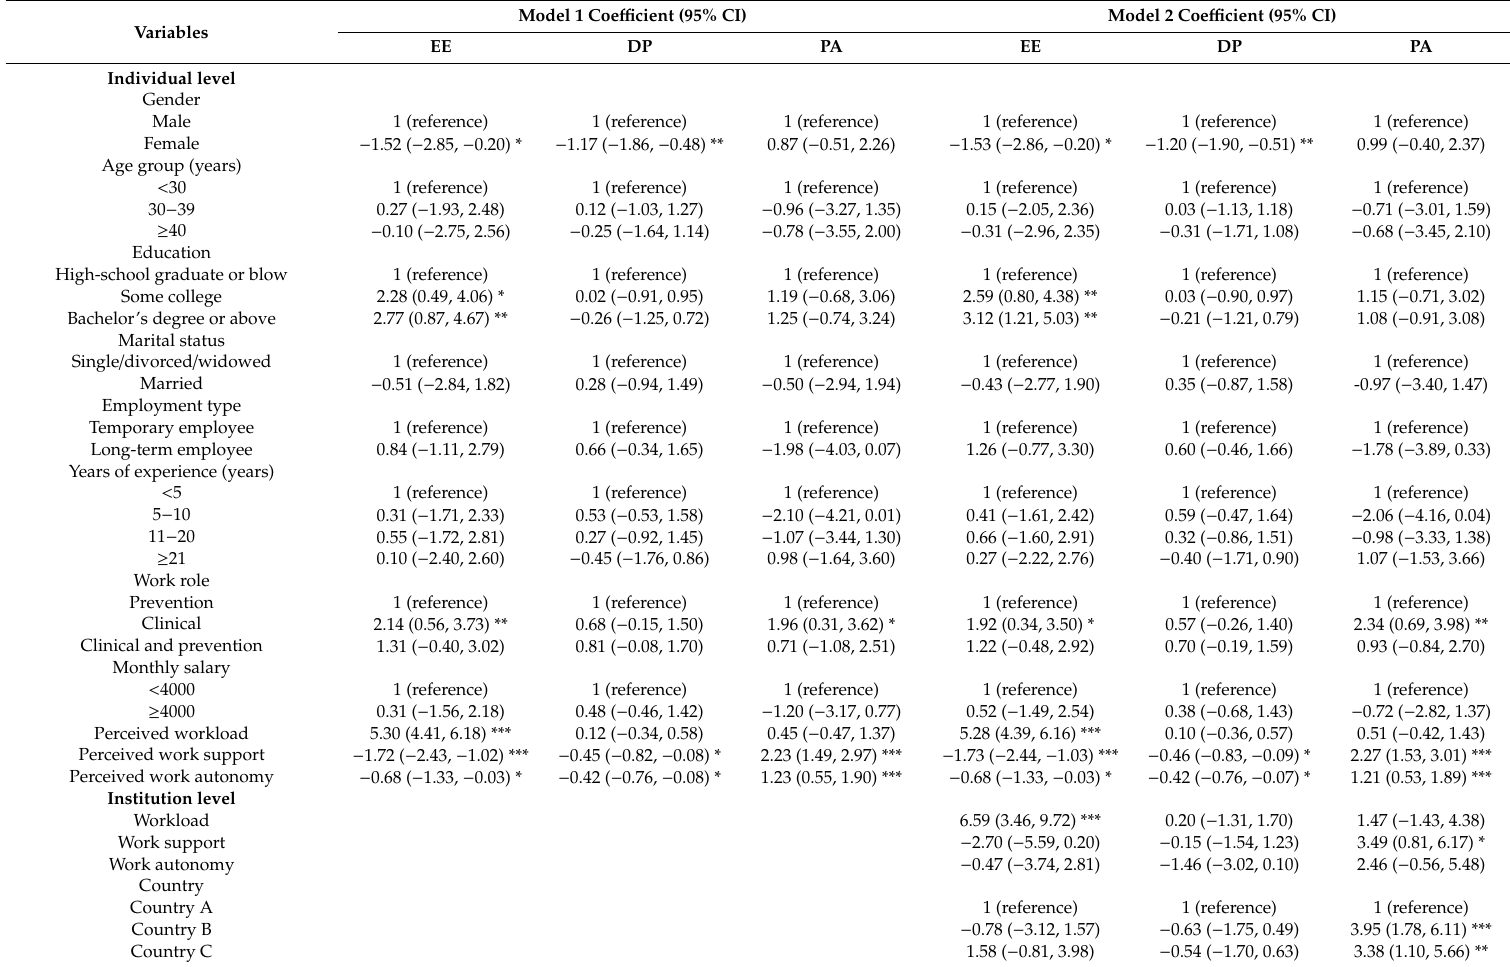
Table 3. Multilevel linear regression analysis of factors related to